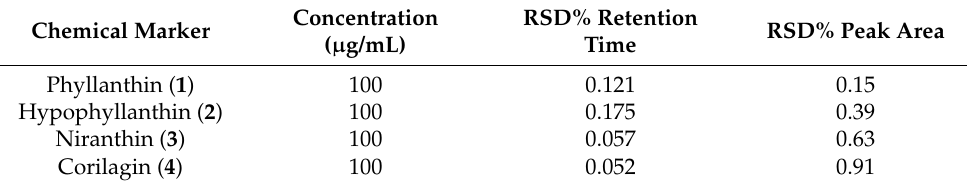
Table 2. Intra-assay precision of compounds.